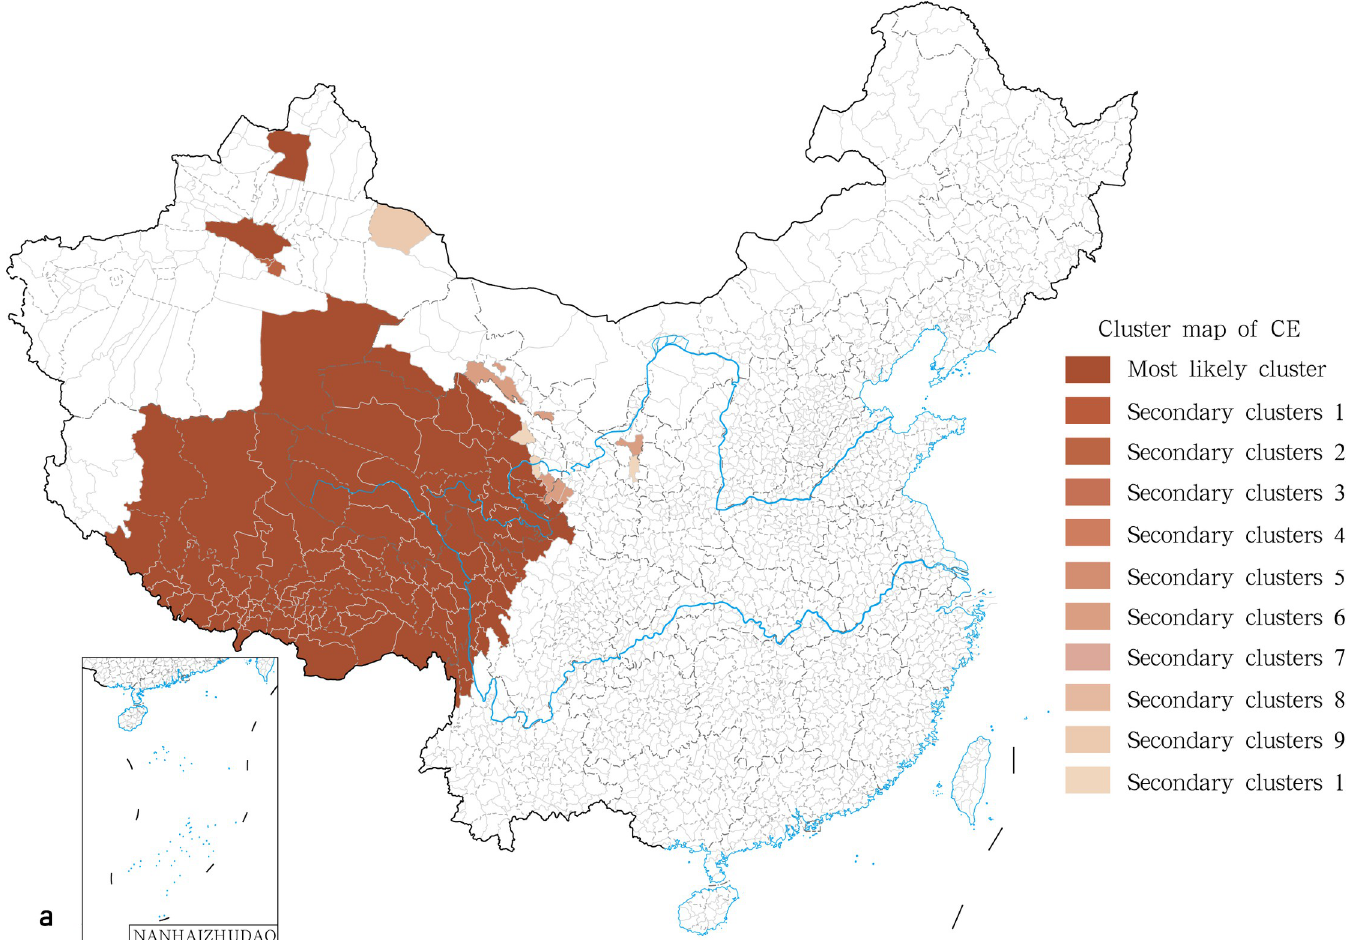
Fig 6. The spatial aggregation analysis of human CE in China in 2018. The base layer is from https://www.webmap.cn/mapDataAction.do?method=forw&resType=